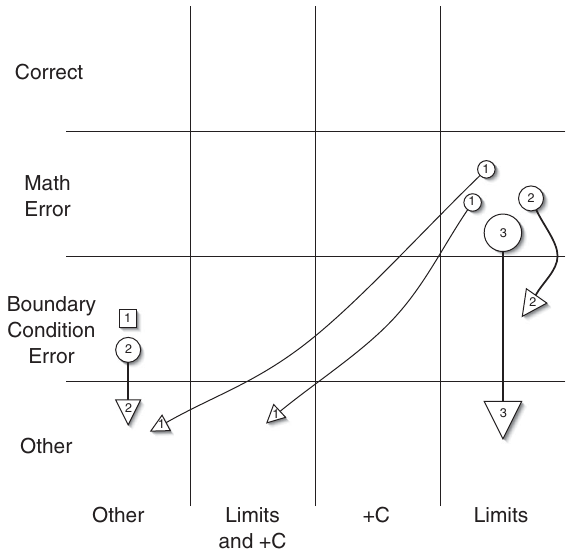
FIG. 13. Consistency plot from year 2. Final examination question had a differen coordinate system, leading to many “ other ” responses that hide information from further